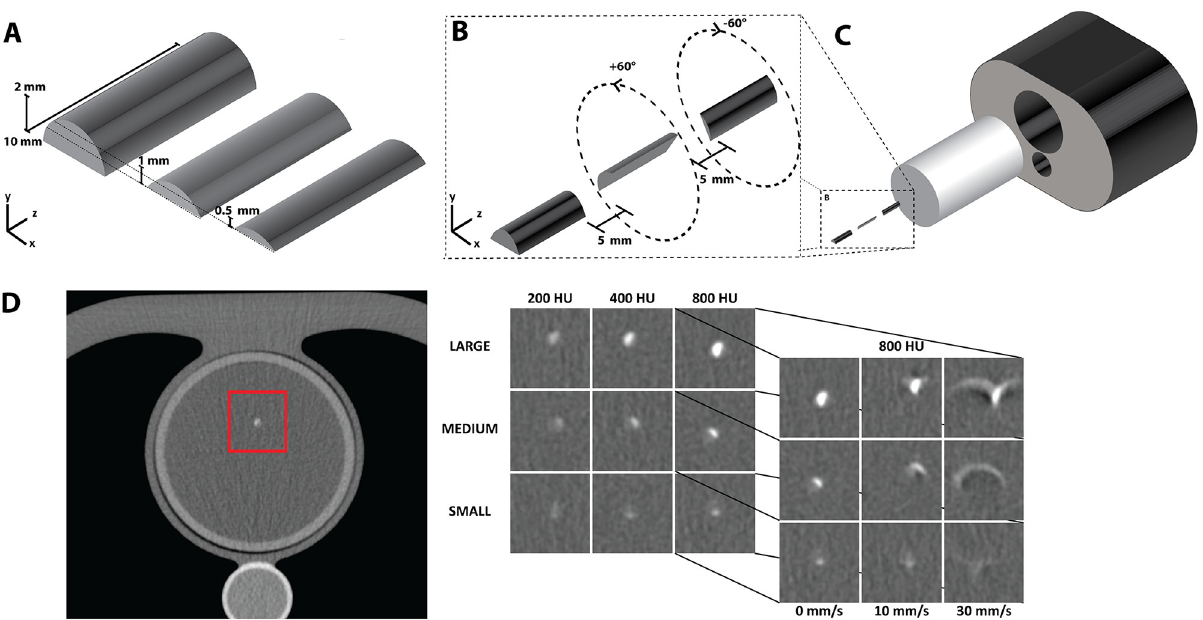
Fig 2. SATI phantom used together with Sim2D motion simulator: (A) Custom-built calcifications of half cylindrical shape with different height levels; (B) An artificial artery containing custom-built calcifications having one of hydroxyapatite density values (800, 400 or 200 mg/cm 3 ) rotated ± 60 degrees with respect to each other; (C) The complete set-up of the SATI phantom containing a custom-built insert placed within Anthropomorphic Thorax; (D) A slice of the large calcification insert with HA density of 200 mg/cm 3 (left); Cropped slices of CT images with calcification inserts of different size and HA density (middle); Cropped slices of CT images of inserts with HA density of 800 mg/cm 3 obtained at different velocity levels (right).